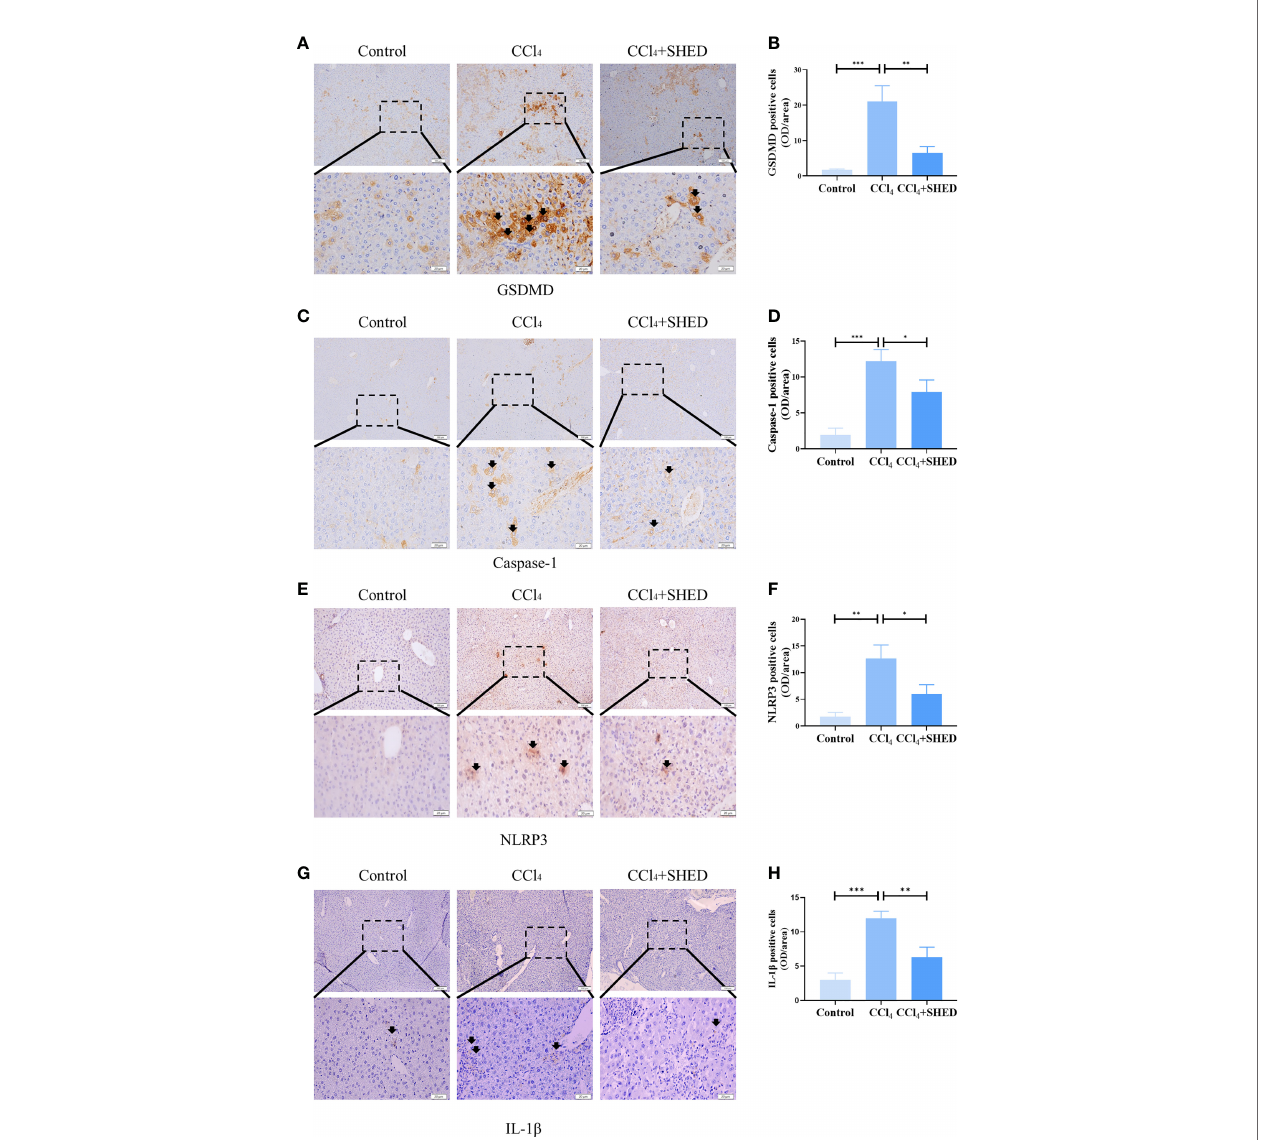
FIGURE 2 | SHED attenuated pyroptosis of hepatocytes in CCl 4 -induced liver cirrhosis. (A, B) Immunohistochemical staining of GSDMD in control, CCl 4 , and SHED transplantation groups (C – H) . The expression of NLRP3, Caspase-1, and IL-1 b in control, CCl 4 , and SHED transplantation groups, as assessed by immunohistochemical staining. Scale bar: 100 and 20 m m. *p < 0.05, **p < 0.01, and ***p < 0.001. Graph bars show the mean ± SD. All of the assays were performed in triplicate. NLRP3, NOD-like receptor family pyrin domain containing 3; GSDMD, gasdermin D; SHED, stem cells from human exfoliated deciduous